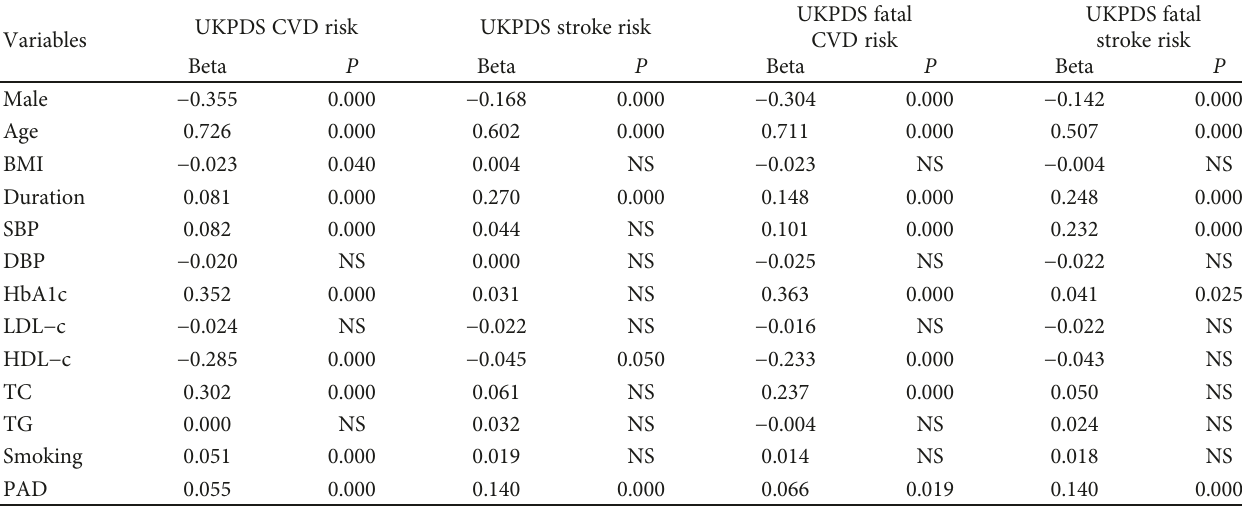
Figure 1: Age-related prevalence of CHD risk and stroke risk in diabetes patients. CHD: coronary heart disease; PAD: peripheral arterial disease; ABI: ankle-brachial index. PAD group: ABI ≤ 0 9 or ABI > 1 4 ; non-PAD group: 0 9 < ABI ≤ 1 4 . Table 3: Multivariate linear regression analysis of risk factors for CHD and stroke as estimated using the UKPDS risk engine.